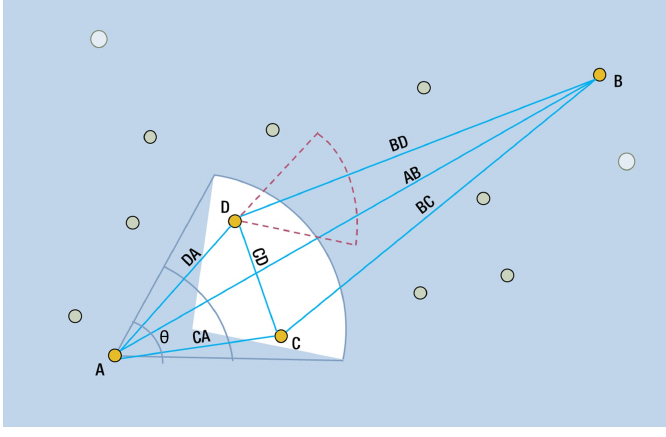
Figure 10. Data Forwarding Techniques in Focused Beam Routing (FBR)